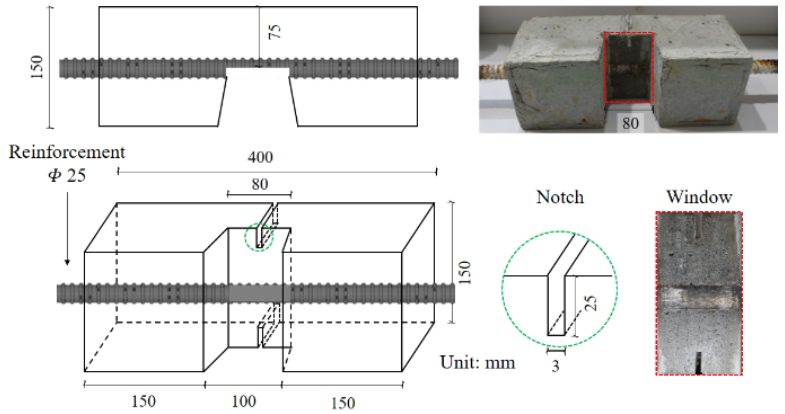
Figure 1. Geometry of re-cast specimen with details of notch and window Reprinted with permis- sion from [32]. 2021, Elsevier.